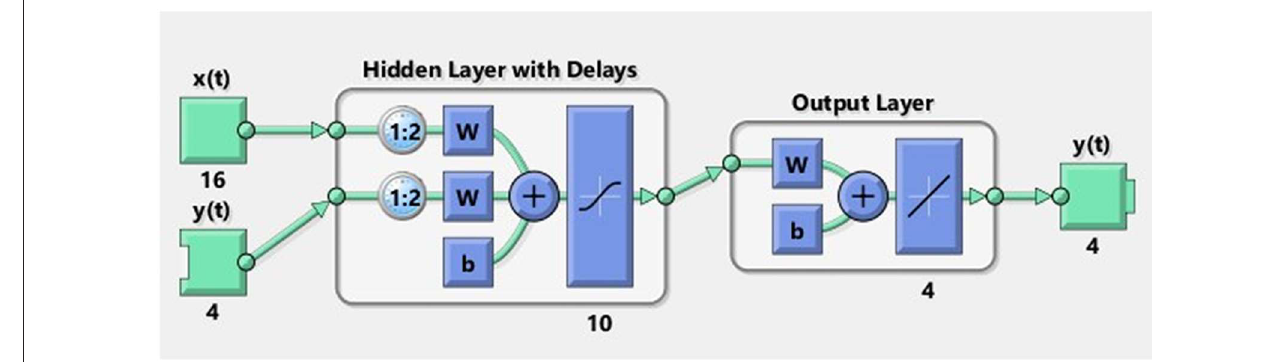
FIGURE 12 | Neural network diagram for the case study.